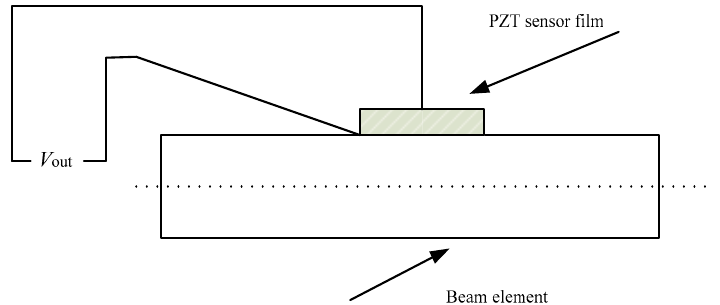
Figure 4. One PZT sensor film is bonded on the beam element.